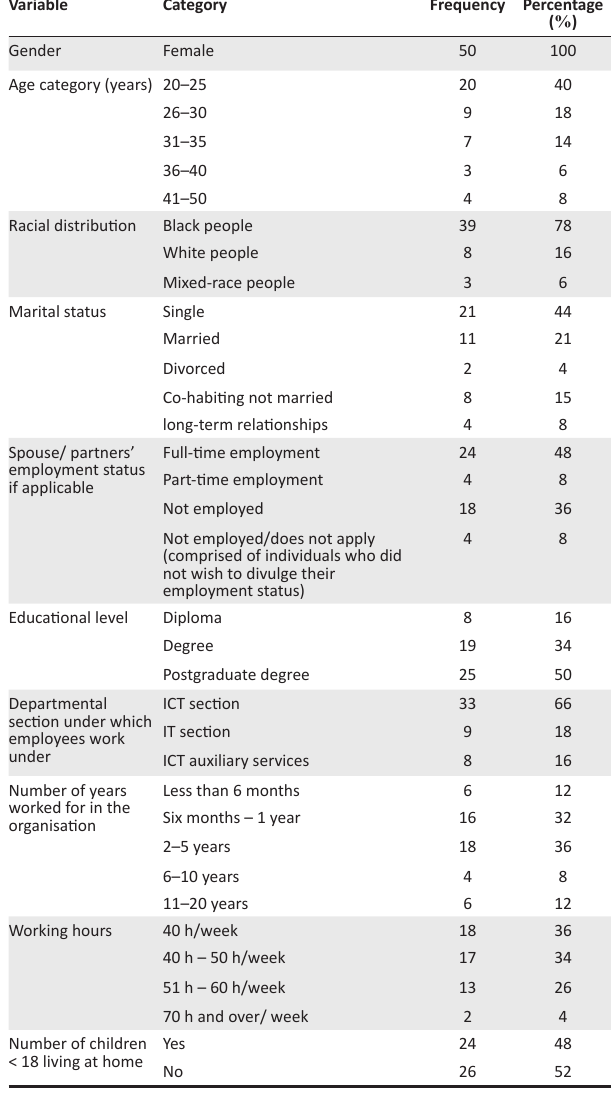
TABLE 2: Demographic profile of the sample